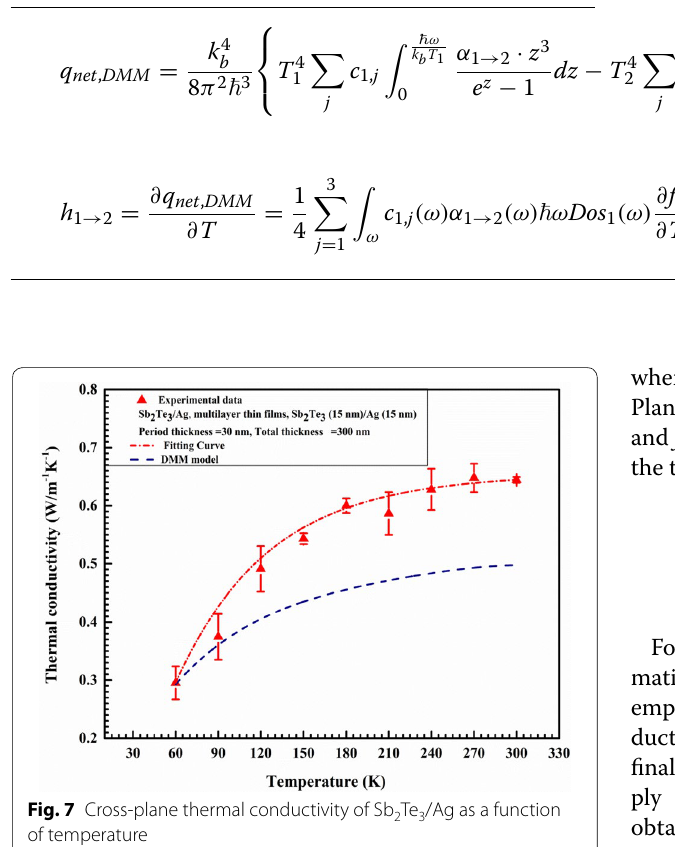
Fig. 7 Cross‑plane thermal conductivity of Sb 2 Te 3 /Ag as a function of temperature